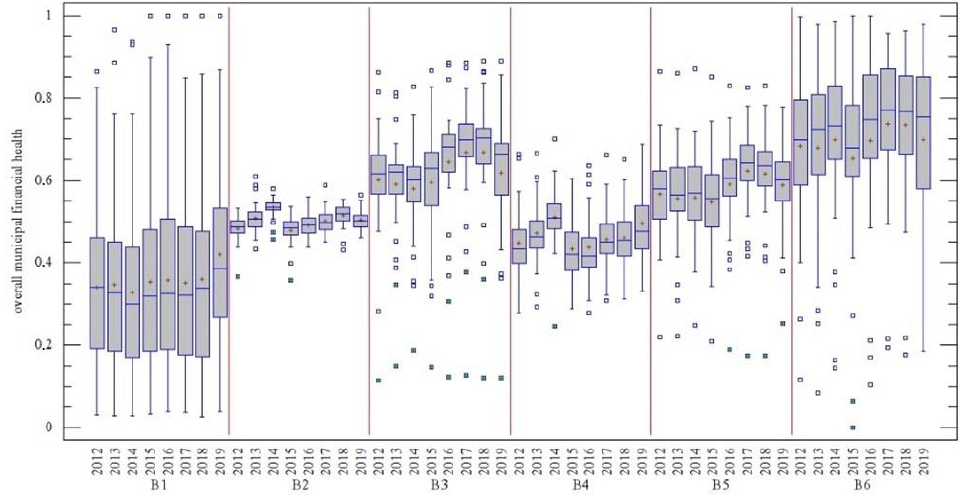
Figure 3. The overall financial health of municipalities based on two indicators (B1, B2, B3, B4, B5, and B6) during the 2012–2019 period.